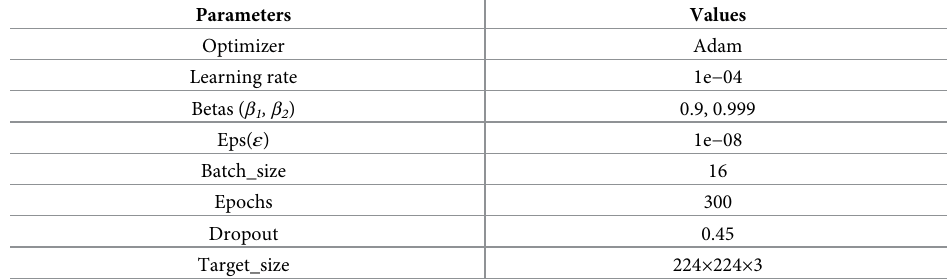
Table 2. Hyperparameters of Impro-ResNet50